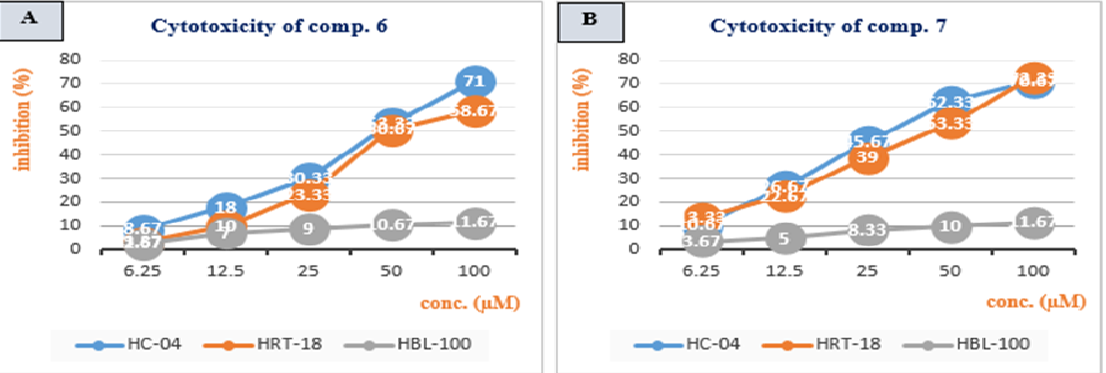
Figure 3. Concentration-growth inhibition curve of the tested compounds against hepatic carcinoma cells (blue), colon adenocarcinoma (orange) and healthy breast cells (gray). (A): the cytotoxicity of compound 6. (B): the cytotoxicity of compound 7